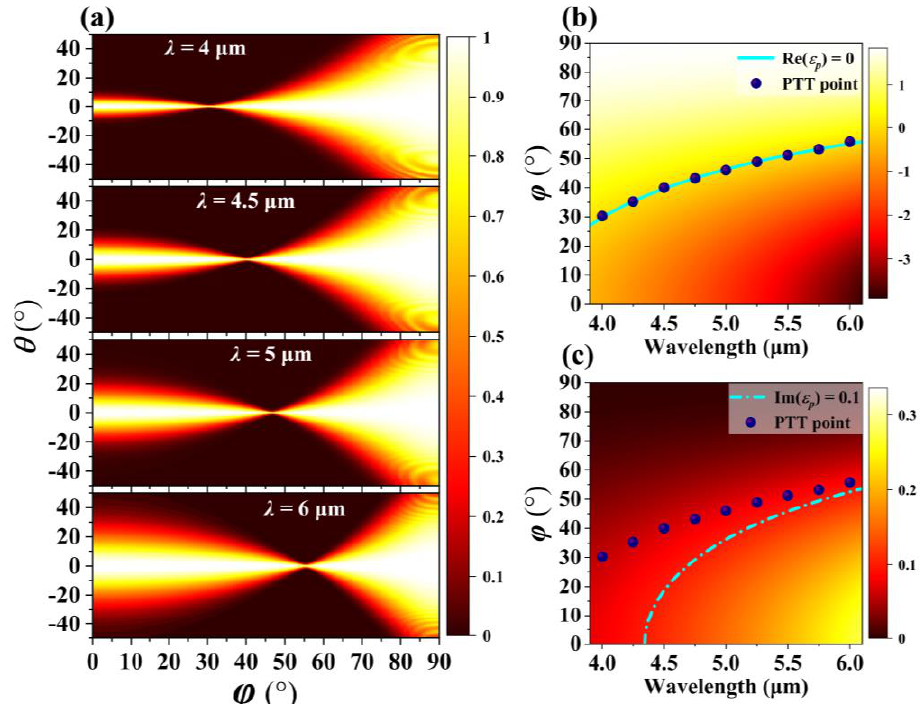
Figure 6. ( a ) Numerically simulated optical transmission as a function of the angle ϕ between the incidence plane ( p - z plane) and y - z plane, and incident angle θ when λ = 4, 4.5, 5, and 6 µ m, respectively. ( b ) Re( ε p ) and ( c ) Im( ε p ) as function of λ and ϕ .